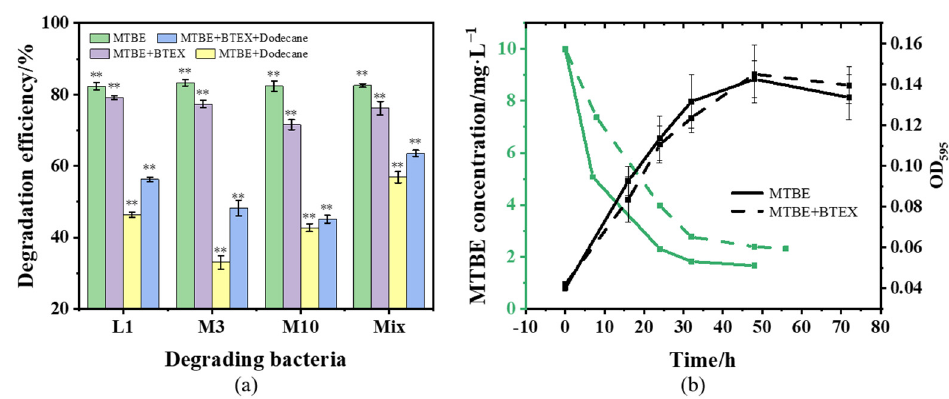
Figure 3. Effect of gasoline organic components on MTBE removal. ( a ) Biodegradation of MTBE in the presence of various gasoline organic components. ( b ) Time course for MTBE degradation and strain growth with or without the addition of BTEX. ** represents p < 0.01.